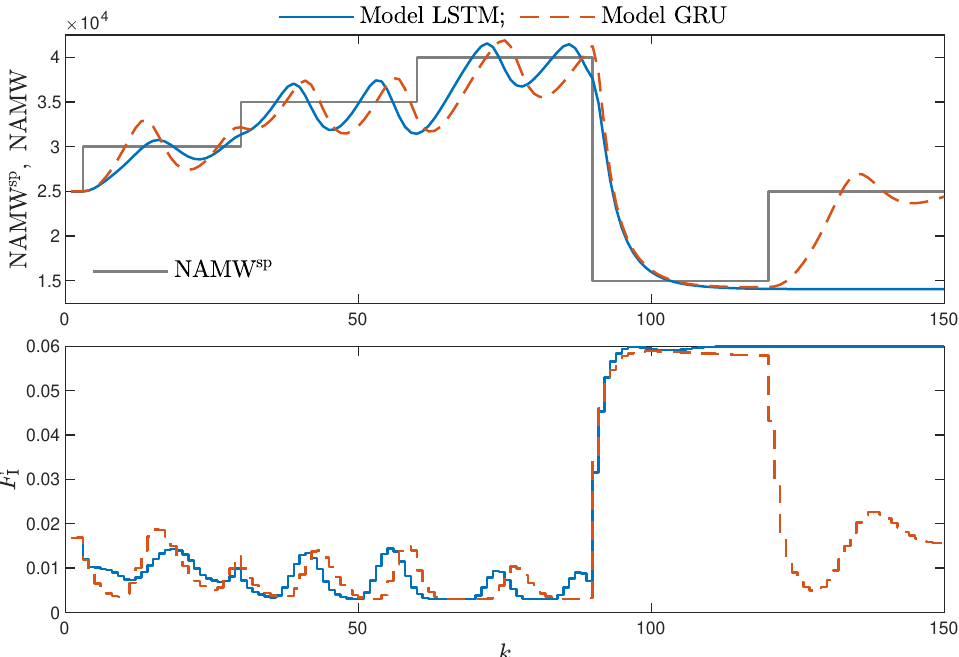
Figure 18. The polymerisation reactor: MPC results with the LSTM and GRU models for n N = 1, n A = n B =